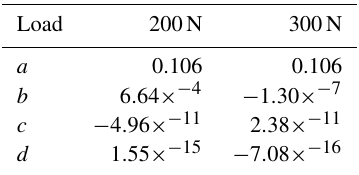
Table 1. The technical parameters of the multifunction friction and wear tester.